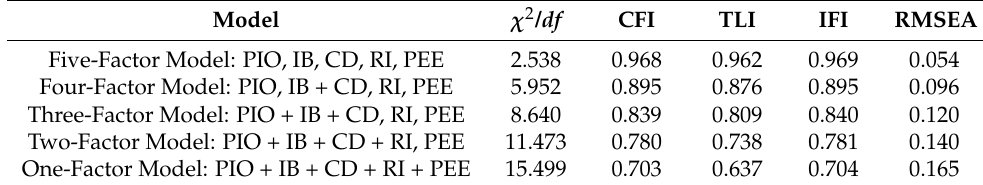
Table 3. Confirmatory factor analysis